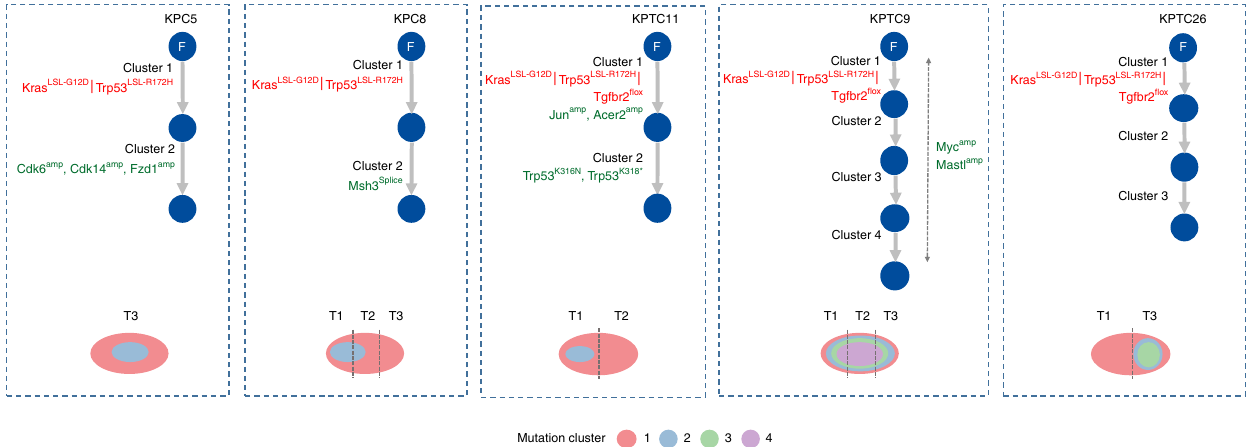
Fig. 4 Linear tumor phylogeny in KPC/KPTC mice. Mutation cluster cancer cell prevalence was compatible with a linear evolutionary pattern in fi ve mice based on SCHISM analysis, which reconstructs tumor phylogeny as a hierarchy of mutations acquired by cancer cells during the process of tumorigenesis. The schematic diagram beneath each tumor phylogeny depicts the hierarchical order of subclones identi fi